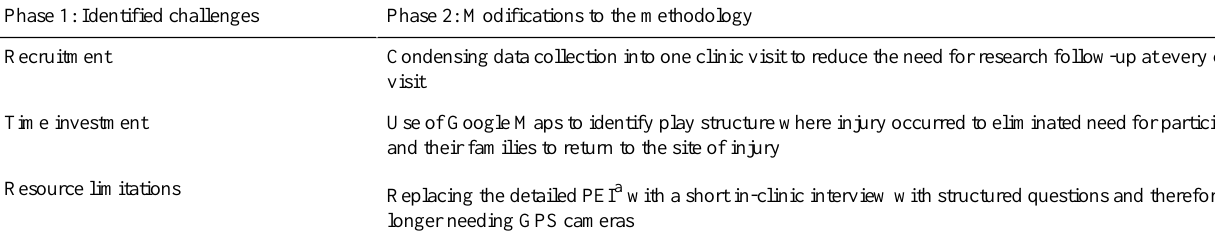
Table 1. Overview of modifications to the